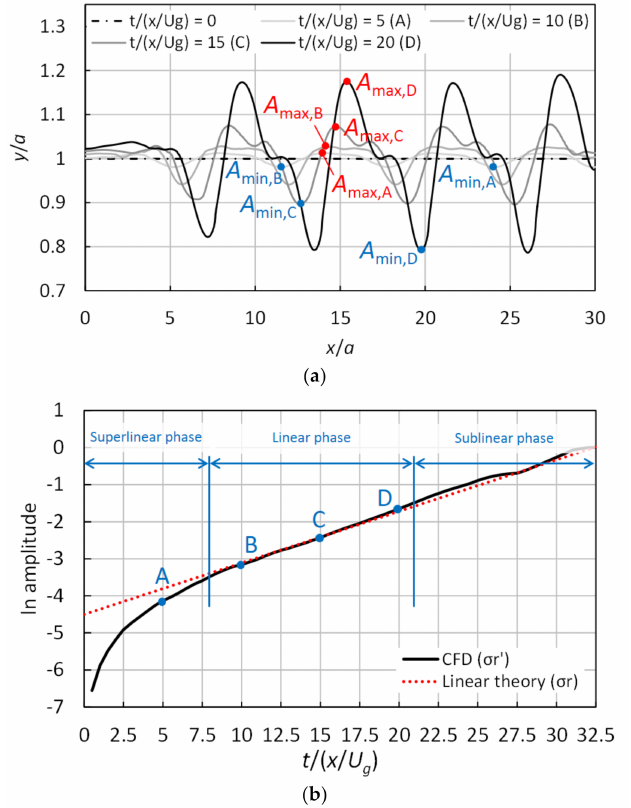
Figure 3. Time variations of the disturbance on the gas sheet surface, in the case of 3000 ( X direction) × 400 ( Y direction) cells, C α = 0, and We g = 2: ( a ) a visualization of the upper disturbed interface and ( b ) a natural logarithm of the disturbance amplitude.